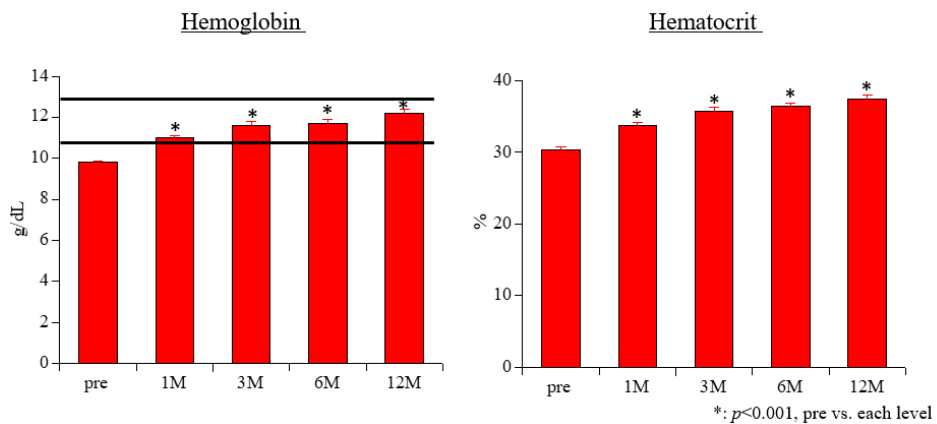
Figure 1. Changes in the levels of hemoglobin and hematocrit over 12 months of treatment with continuous erythropoietin receptor activator.